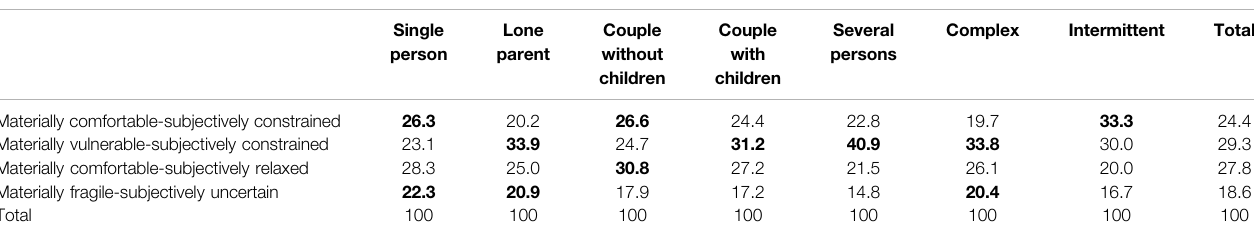
TABLE 4 | Pro fi les of social impact by household type (in